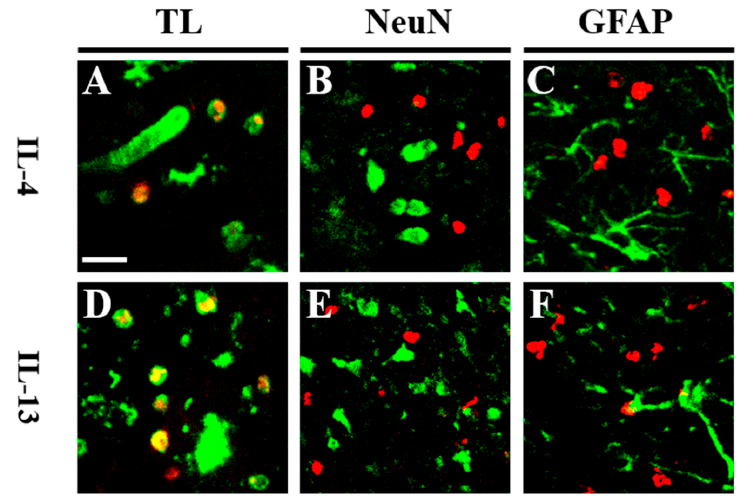
Figure 3. pKr-2-induced IL-4 and IL-13 are co-localized within activated microglia/macrophages